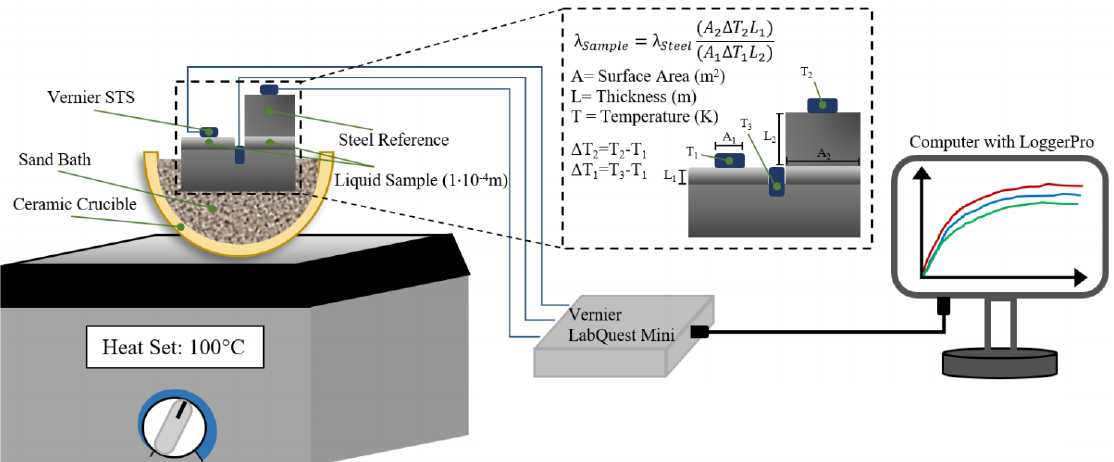
Figure 4. Schematic of the experimental setup used for measuring the thermal conductivity of pure Ga and Ga-In alloys using the modified comparative cut bar method.